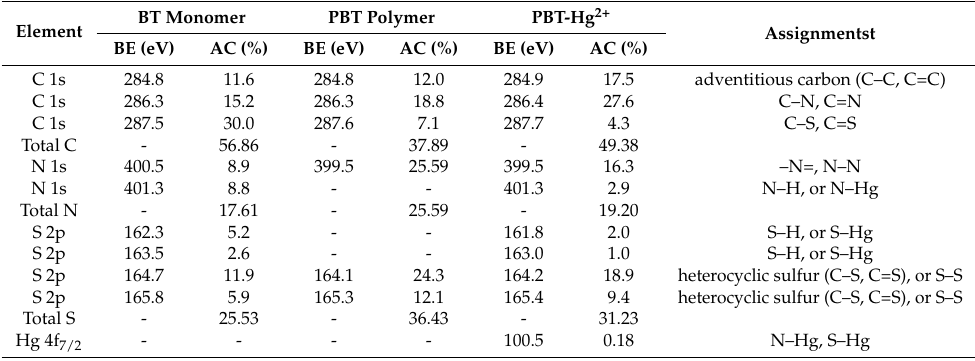
Table 1. Assignment of main XPS spectral bands based on their binding energies (BEs) and atomic concentrations (ACs) for BT, PBT, and Hg 2+ -loaded